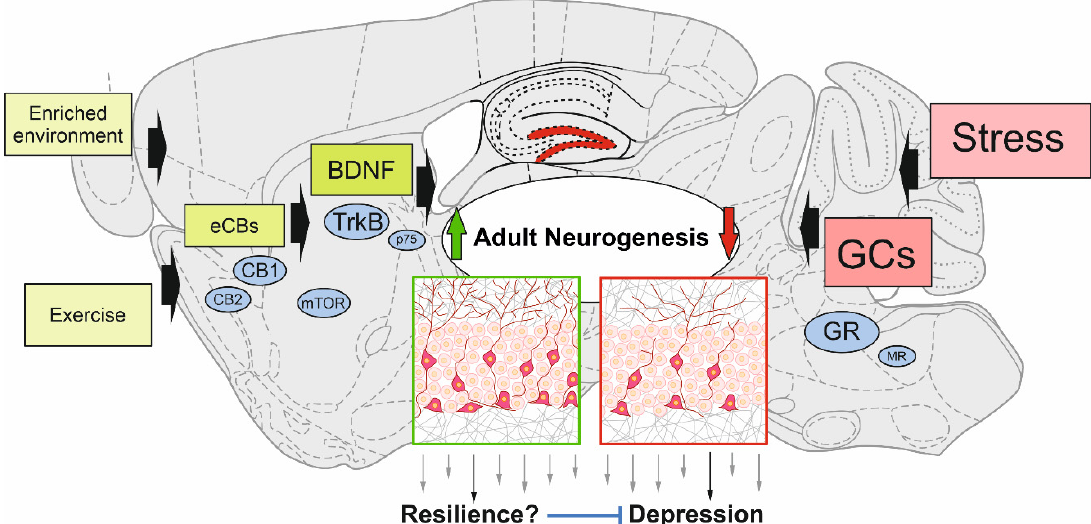
Figure 1. Schematic view of modulating factors of adult hippocampal neurogenesis. Enriched environment, exercise, and molecular players (e.g., endocannabinoids (eCBs) and brain-derived neurotrophic factor (BDNF)) have the potential to upregulate the generation of adult-born neurons in the dentate gyrus. This could confer resilience to the development of depressive-like symptoms through the stress-related decline of adult neurogenesis induced by glucocorticoids (GCs). The main signaling pathways of positive modulators and stress are depicted: cannabinoid receptor type-1 and -2 (CB1; CB2); mammalian target of rapamycin (mTOR); tropomyosin receptor kinase B (TrkB); p75 neurotrophin receptor (p75); glucocorticoid receptor (GR); mineralocorticoid receptor (MR).